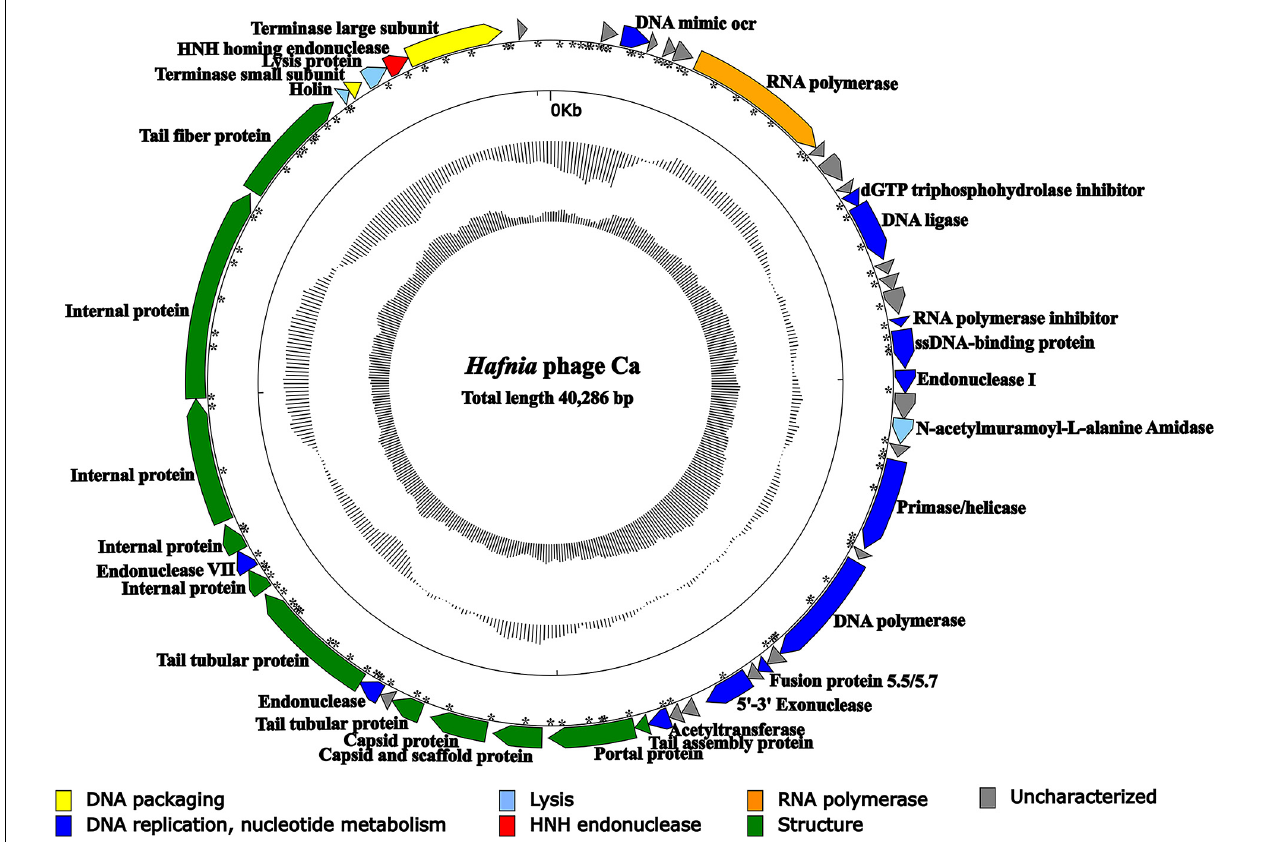
FIGURE 4 | Genomic map of Hafnia phage Ca. The direction of the arrow indicates the direction of each gene; the functional groups is distinguished by color: yellow stands for DNA packaging, blue for DNA replication and nucleotide metabolism, azure for lysis, orange for RNA polymerase, green for structure, red for HNH endonuclease, and gray indicates hypothetical protein. Asterisks indicate predicted